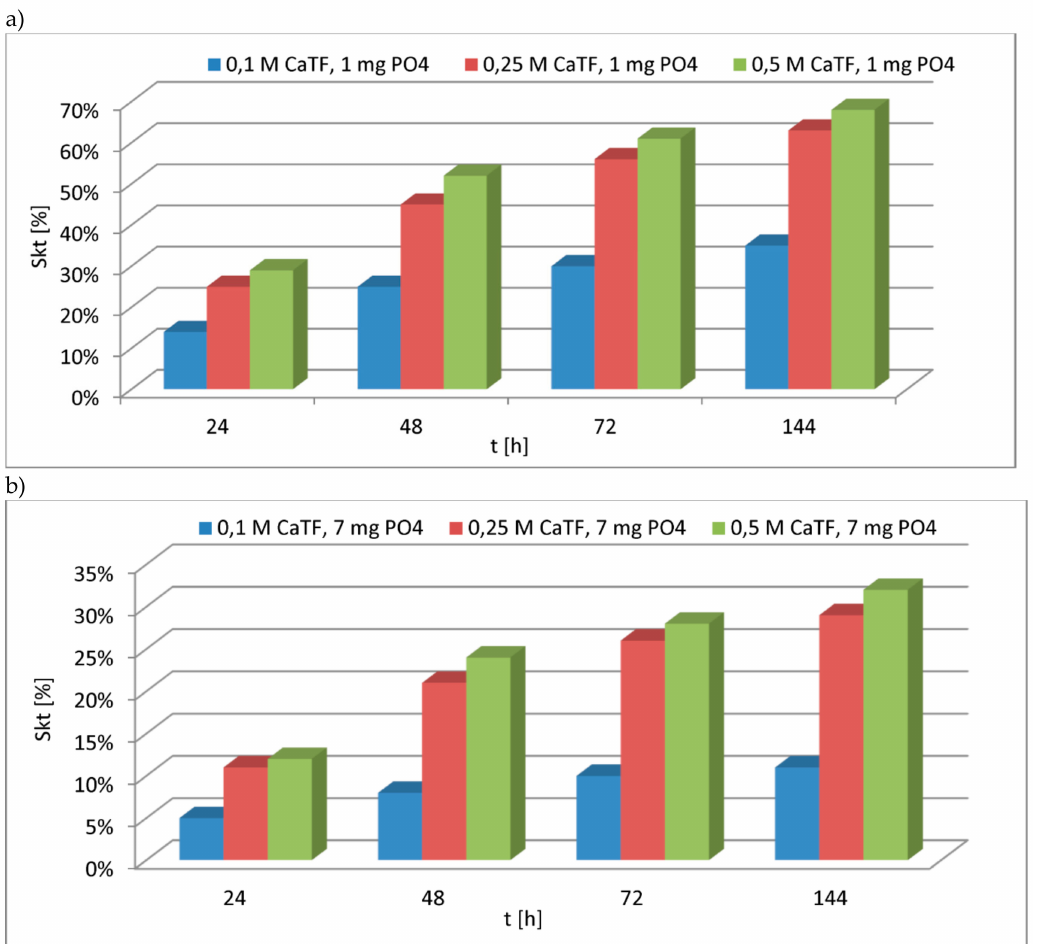
Figure 1. The percentage phosphate removal e ffi cacy depending on the molar concentration of Ca(OH) 2 used for the modification of a tu ff of Filipowice (TF) sample. The provided results are an average of three designations. ( a ) Experiment parameters: Cp = 1.072 [mg / dm 3 ]; dose = 5.0 [g / dm 3 ]; time = 24–144 h; ( b ) experiment parameters: Cp = 7.067 [mg / dm 3 ]; dose = 5.0 [g / dm 3 ]; time = 24–144